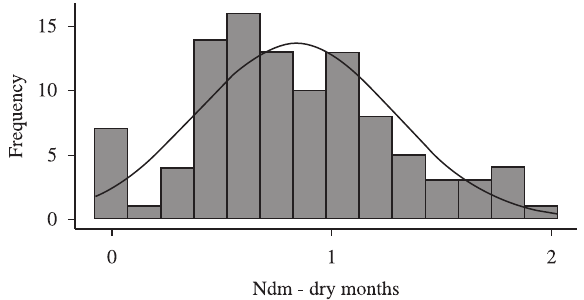
Table 5. Descriptive statistics for the population variables of I